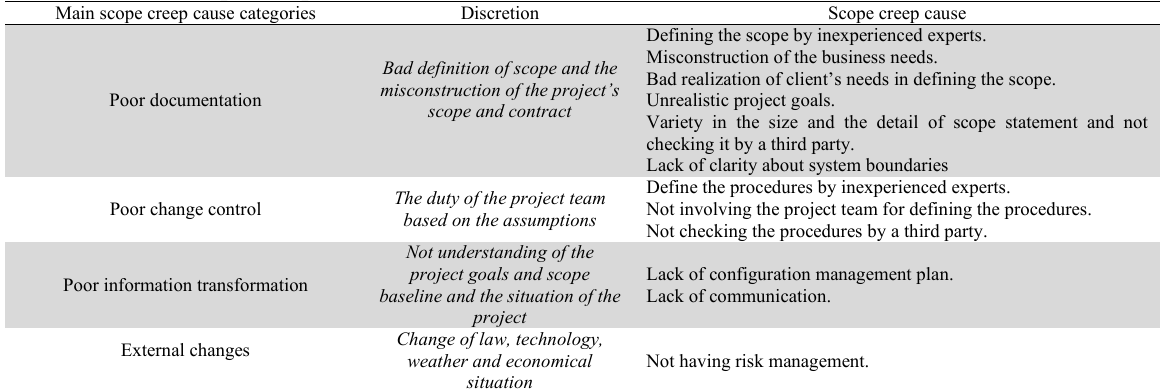
Main causes of scope